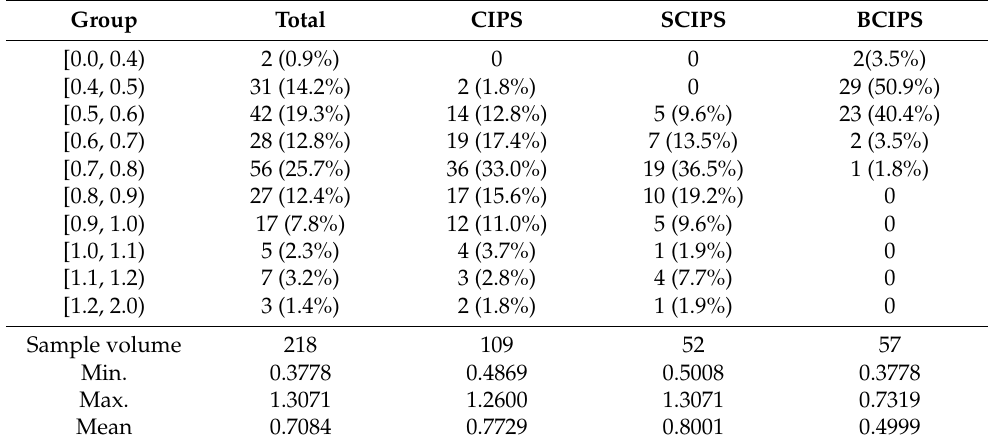
Table 3. The Technical Efficiency (TE) of Different Beef Calf Production Systems Calculated by the CRS-DEA